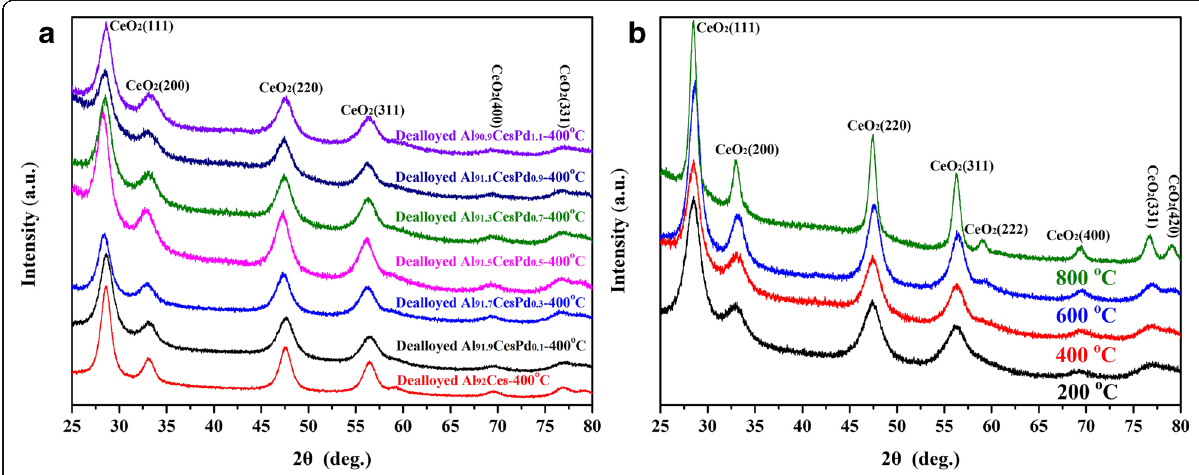
Fig. 2 XRD patterns of Al 92 − X Ce 8 Pd X ( X = 0.1, 0.3, 0.5, 0.7, 0.9, and 1.1) dealloyed at 400 °C ( a ) and the XRD patterns of dealloyed Al 91.3 Ce 8 Pd 0.7 alloys calcined at different temperatures ( b